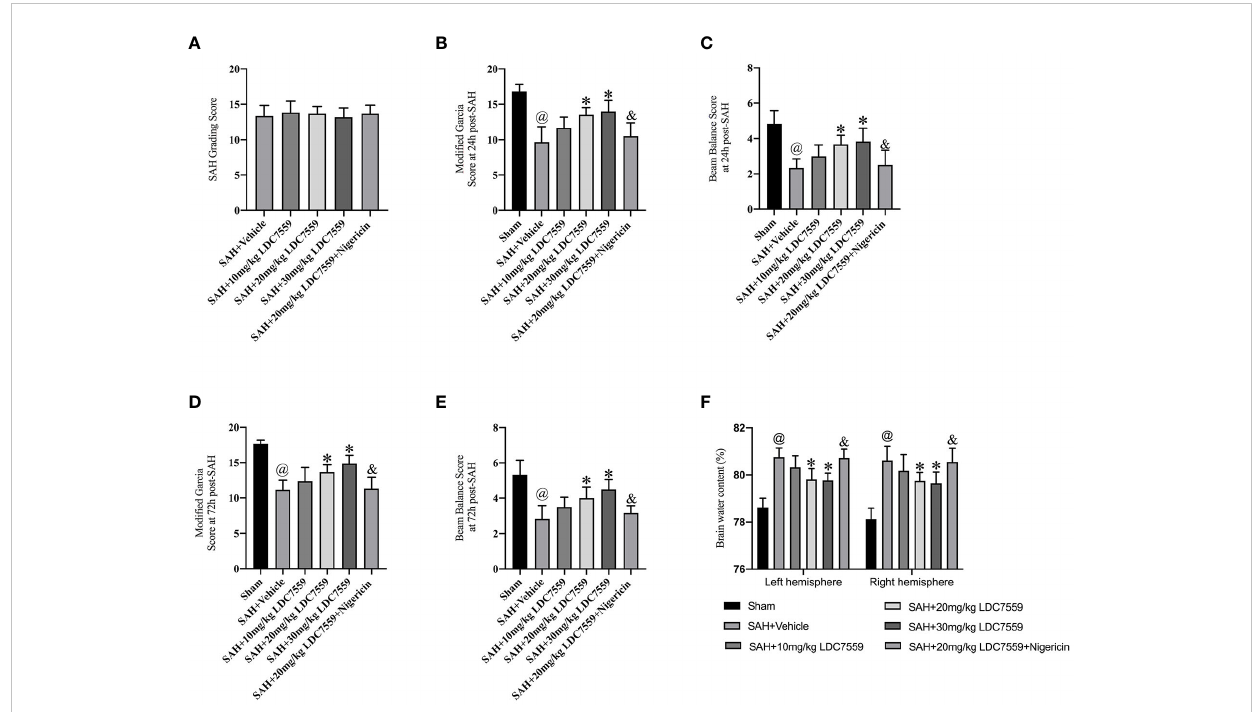
FIGURE 1 LDC7559 improved short-term neurological outcome after SAH. (A) SAH grading scores in all experimental groups (n = 6 per group). Quanti fi cation of the modi fi ed Garcia score (B) and beam-walking test (C) at 24 h post-SAH (n = 6 per group). Quanti fi cation of the modi fi ed Garcia score (D) and beam-walking test (E) at 72 h post-SAH (n = 6 per group). Measurement of brain edema in all groups at 24 h post-SAH (F) (n = 6 per group). Values are presented as the mean ± SD. @ P < 0.05 compared with sham group, * P < 0.05 compared with SAH + vehicle group, & P < 0.05 compared with SAH + 20mg/kg LDC7559 group.